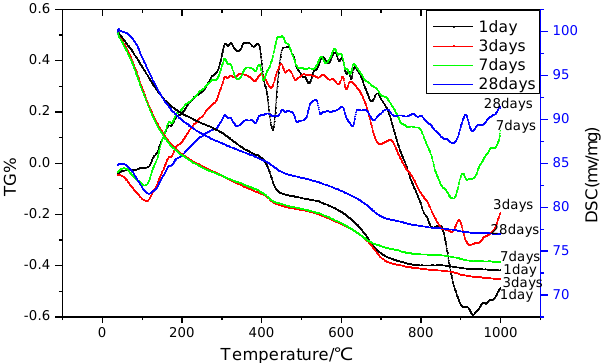
Figure 4. Thermogravimetric-differential scanning calorimetry (TG-DSC) curves of the products of the reaction of nano-SiO 2 with Ca(OH) 2 .